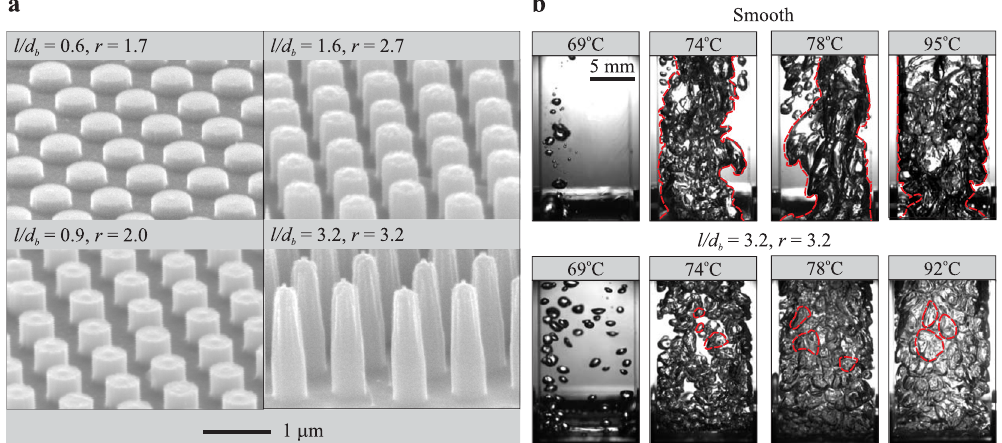
Figure 1. SEM images showing nanopillar substrates of different pillar dimensions: the ratio l / d b , defined as the ratio between the pillar height l and base diameter d b , and the corresponding surface roughness r are indicated in the labels. ( b ) Representative snapshots showing boiling phenomenon on the smooth substrate (top panel) and the nanopillar substrate having r = 3.2 (bottom panel) at several surface temperatures T . While the smooth surface produces vapour bubbles which have tendency to coalesce (e.g., at T = 74 °C) and form vapour columns (e.g., at T = 78 °C), the nanopillar substrate produce bubbles which have a narrow size distribution tend to evolve separately without merging. The vapour column and bubbles are highlighted by red dashed